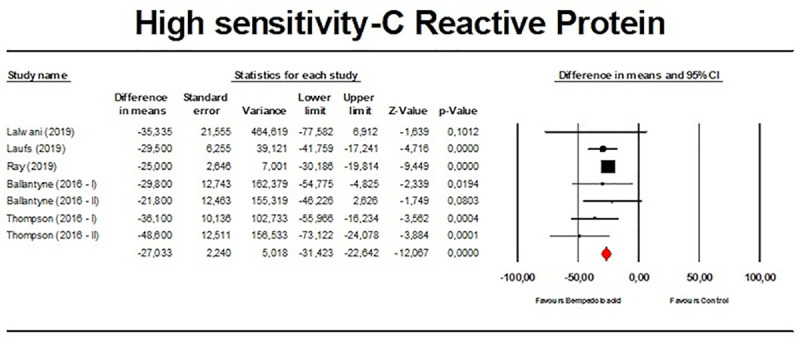
Forest plot displaying mean difference and 95% confidence intervals for the effect of bempedoic acid on plasma levels of high-sensitivity C-reactive protein.